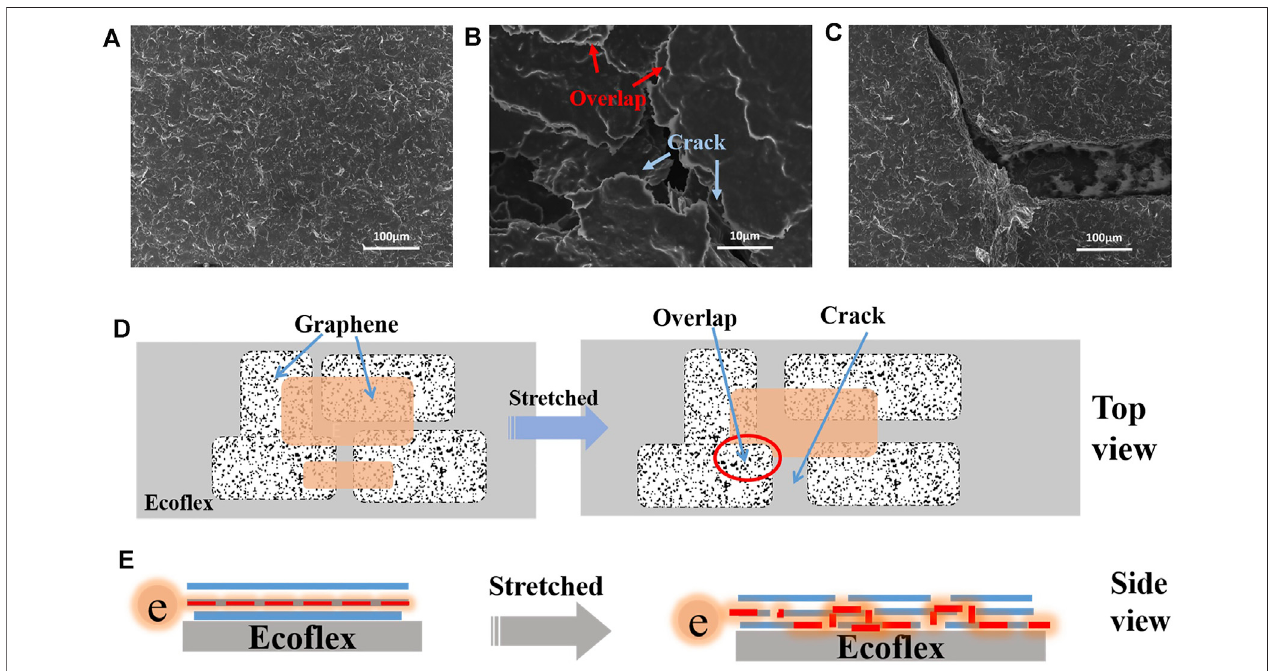
FIGURE 5 | SEM images of the fl exible graphene strain sensor (A) without strain, and (B, C) under a stretched state; schematic structure of the strain sensor with and without strain from (D) the top view and (E) the side view.